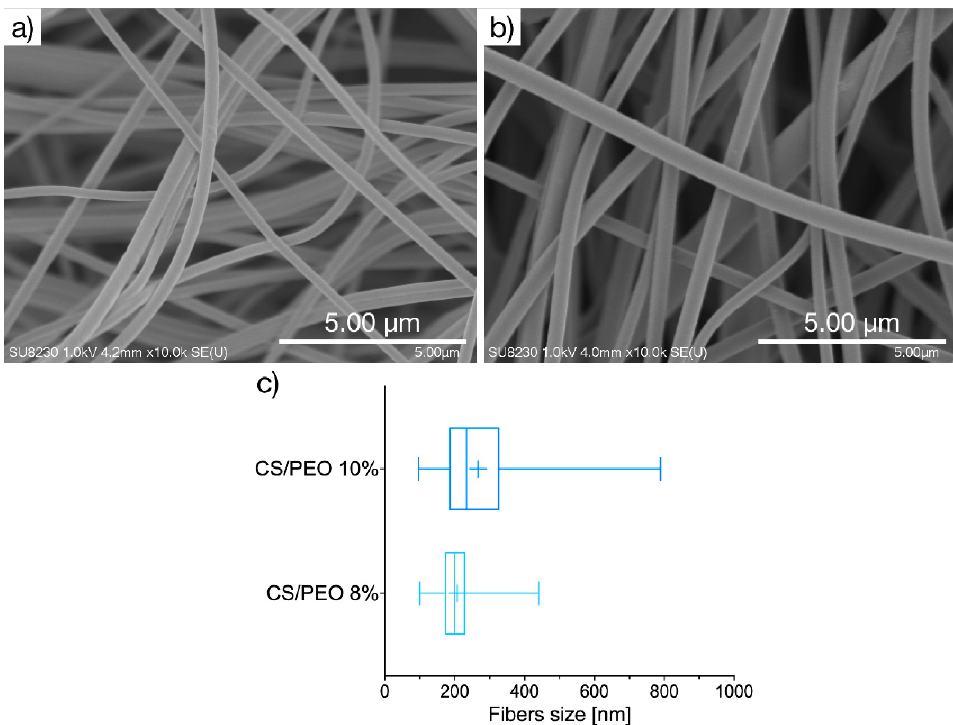
Figure 1. Representative SEM images of CS/PEO nanofibers prepared of: ( a ) 8% or ( b ) 10% ( w / w ) polymer blend solution (magnification ×10,000); ( c ) size distribution box-whiskers graph, where box represents, from the left: 25th percentile, median, and 75th percentile, with + sign for mean value, and whiskers represent minimum and maximum of fiber size distribution.